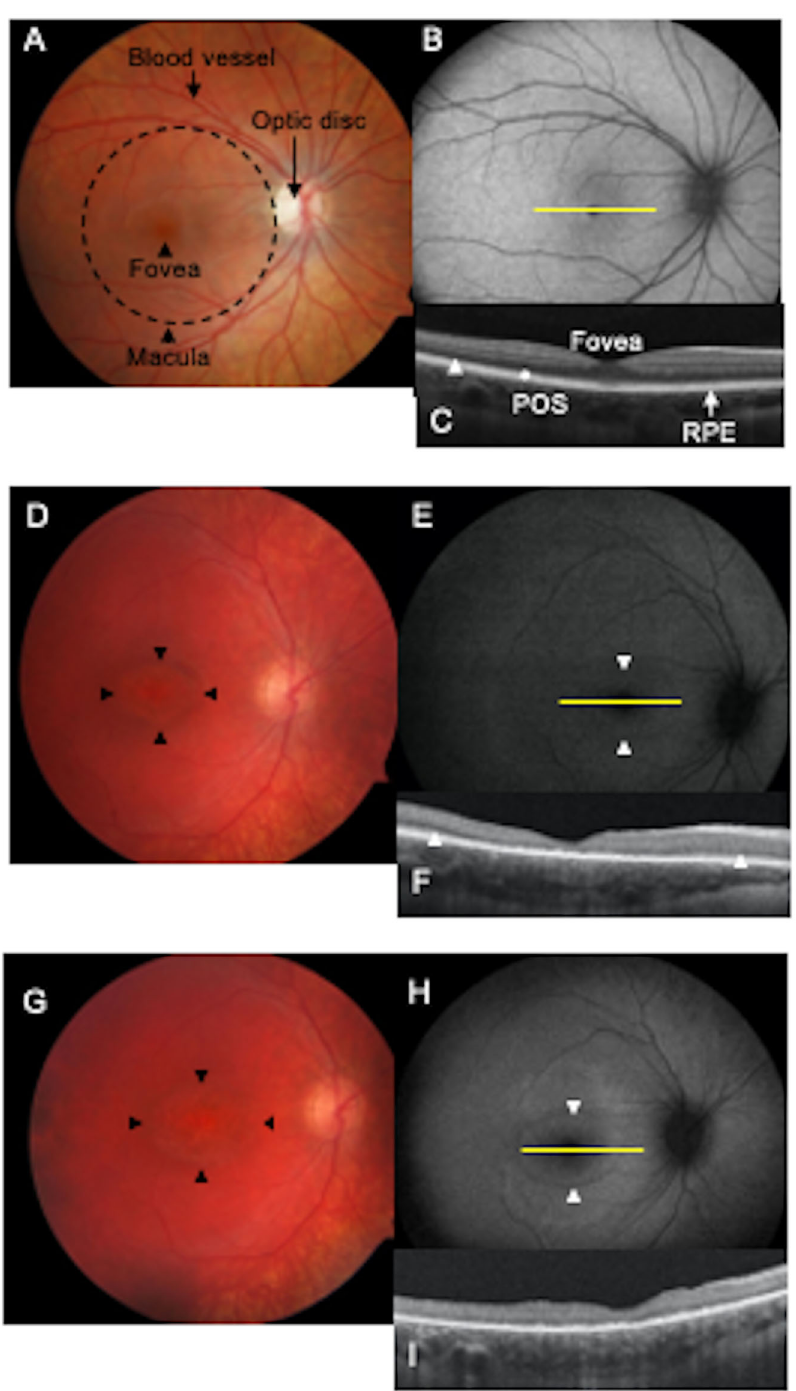
Fig. 9 Longitudinal multimodal imaging of a CLN3 disease patient is consistent with auto fl uorescent changes in photoreceptor – RPE complex preceding photoreceptor cell loss. A – C Multimodal imaging of a normal eye. A Fundus photograph of a normal right eye. Dashed circle outlines roughly the macula. The fovea is marked with an arrowhead in the center of the macula. Blood vessel and optic disc are also labeled (yellow lines). B Fundus auto fl uorescence (FAF) image of a normal right eye. Note the optic disc and the blood vessels are dark as they do not exhibit auto fl uorescence. Optical coherence tomography (OCT) section of the retina through the fovea (yellow line in B ) is shown. C The photoreceptor nuclei are packed in the hypo-re fl ective band (arrowhead). The retinal pigment epithelium (RPE) is the linear hyper-re fl ective band marked by a line. Photoreceptor outer segments (POS) are present in the area between the photoreceptor nuclei layer and the RPE as alternating hyper-and hypo-re fl ective linear bands (marked with an asterisk). D – I Multimodal imaging in a 7-year-old patient with CLN3 disease. D Fundus photograph showing bull ’ s eye maculopathy (BEM) outlined with arrowheads. E FAF showing a faint hyperauto fl uorescent annulus at the margin of BEM (arrowheads). F OCT section through the fovea reveals central loss of the photoreceptor nuclear layer as well as the POS layer. The layers are present towards the periphery on either side of the fovea but the layers are thinner than normal (arrowheads). At follow-up at age 8 years, BEM has enlarged (arrowheads in G ), hyperauto fl uorescent annulus has become more diffuse (arrowheads in H ); and the loss of POS and photoreceptor nuclei can be seen across the entire section of the retina ( I ) with a decrease in overall thickness of the retina as well. COMMUNICATIONS BIOLOGY| (2021) 4:161 |https://doi.org/10.1038/s42003-021-01682-5|www.nature.com/commsbio